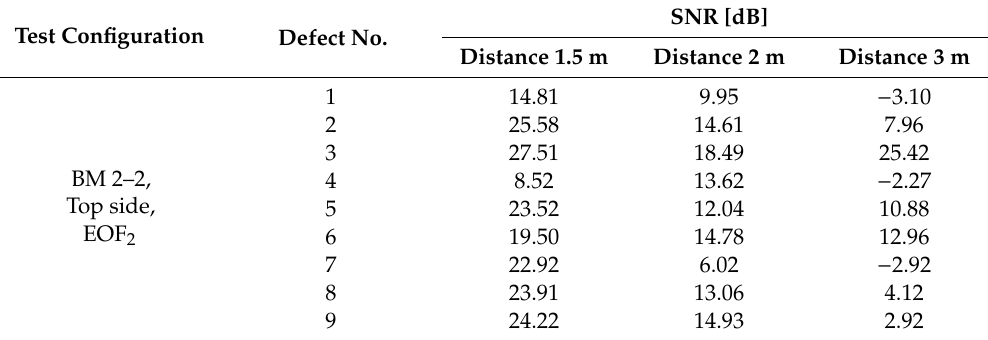
Table 4. SNR values obtained from EOFs presented in Figure 9. Test Configuration Defect